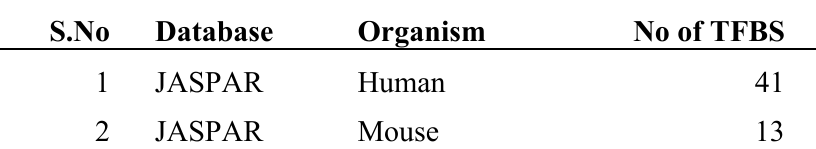
Table 1: Database and the corresponding organism with number of TFBS used in the present study